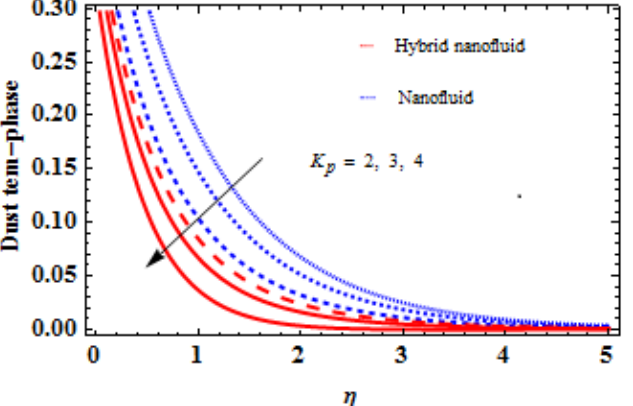
Figure 10. Influence of 𝐾 𝑝 via dust temperature.